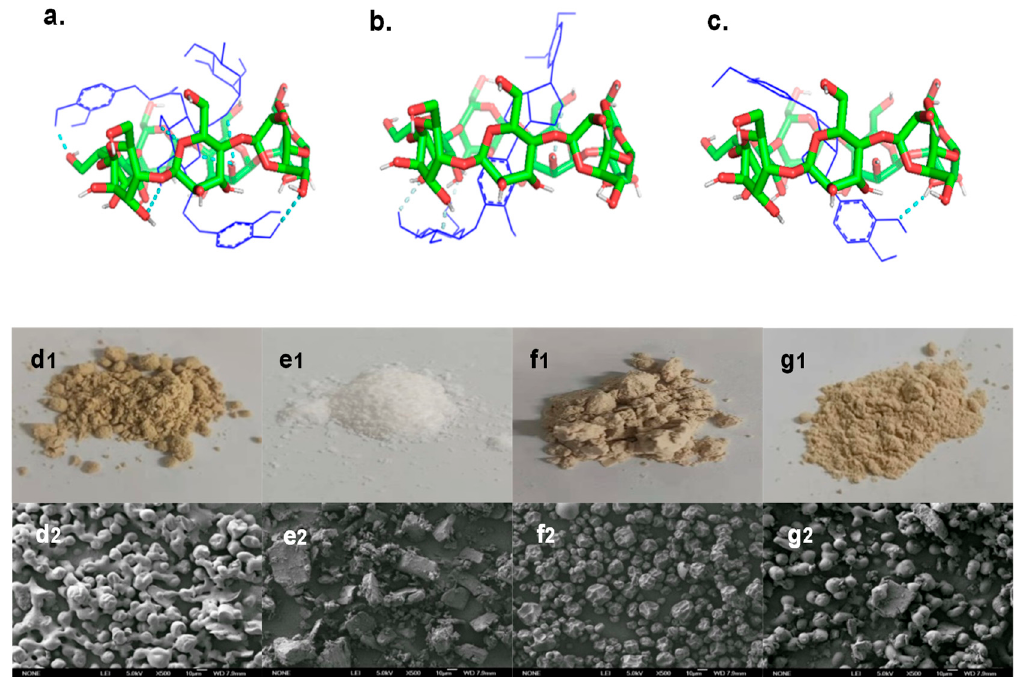
Figure 7. Microstructures of samples and structural optimization and molecular docking of ( a ) forsythoside A/ β -CD IC, ( b ) phillyrin/ β -CD IC and ( c ) phillygenol/ β -CD IC. The sample photos are ( d 1 ) FSE, ( e 1 ) β -CD, ( f 1 ) FSE- β -CD and ( g 1 ) 1:1 FSE/ β -CD, and the SEM images of samples are ( d 2 ) FSE, ( e 2 ) β -CD, ( f 2 ) FSE- β -CD and ( g 2 ) 1:1 FSE/ β -CD PM.